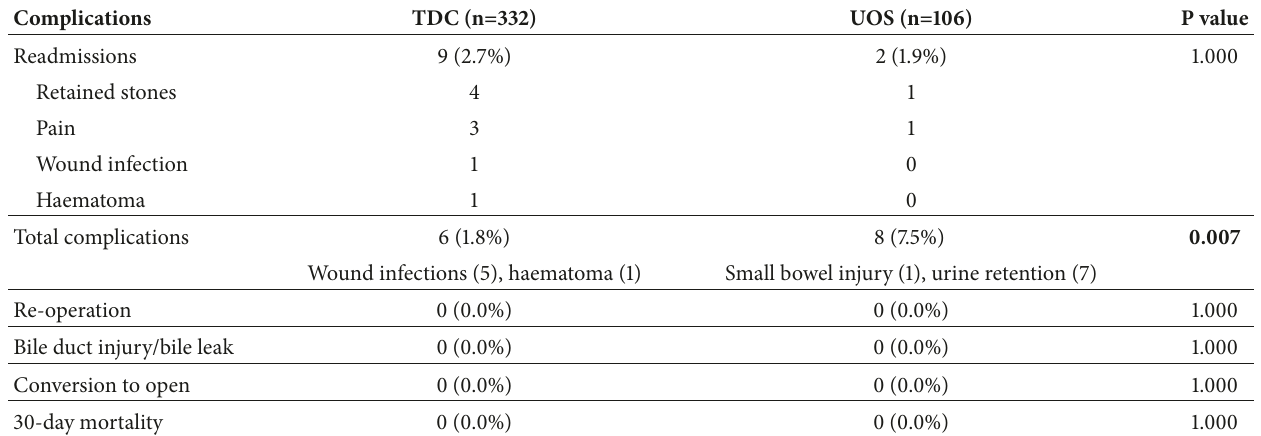
Table 4: Complications: TDC versus